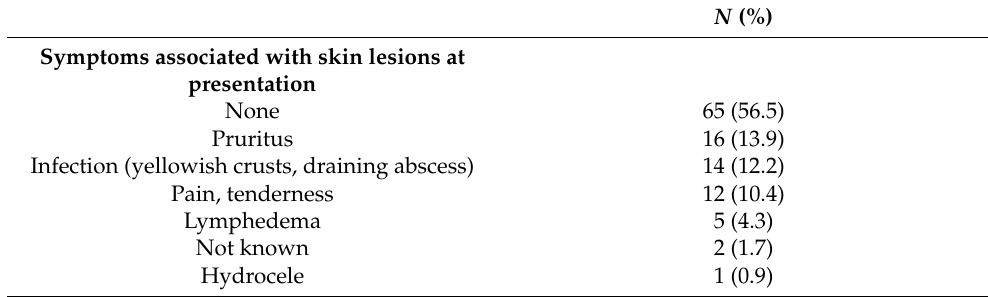
Table 2. Clinical presentation of the skin lesions of patients diagnosed with cutaneous metastasis ( N =